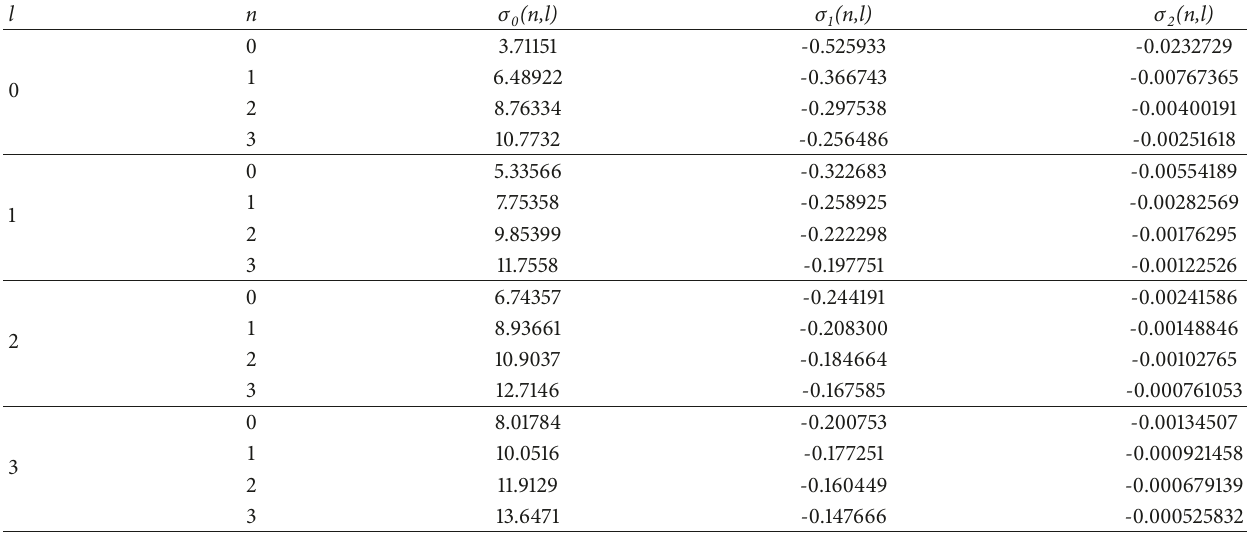
Table 4: Perturbation coefficients of the expansion given as (24) and (26). Notice that corrections to the perturbation expansion do not depend on the potential parameters.